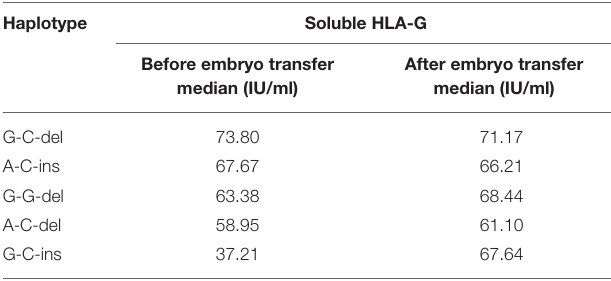
TABLE 5 | Association of HLA-G haplotypes with soluble HLA-G measured before and after embryo transfer in patients with pregnancy.